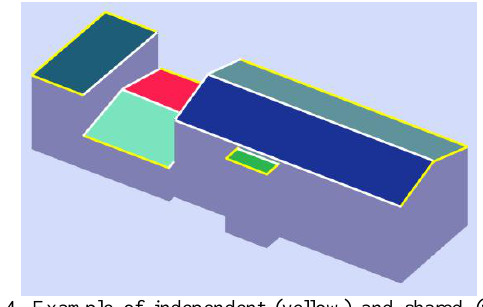
Fig. 4. Example of independent (yellow) and shared (white) edges.